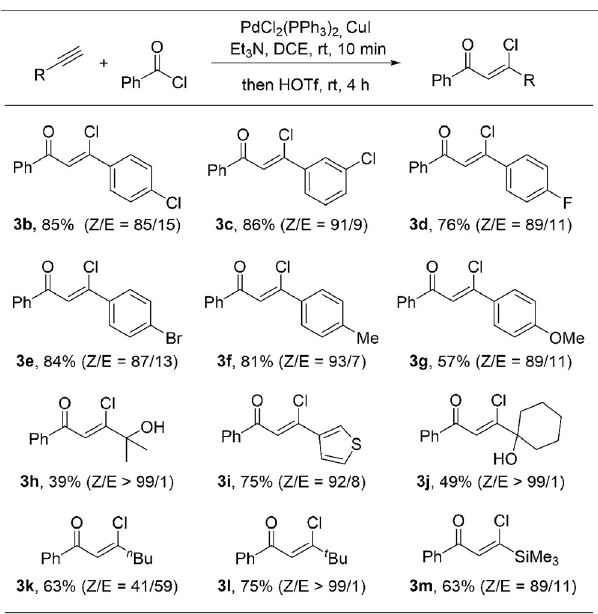
TABLE 2 | Substrate scope of alkynes a , b . TABLE 3 | Substrate scope of acyl chloride a , b